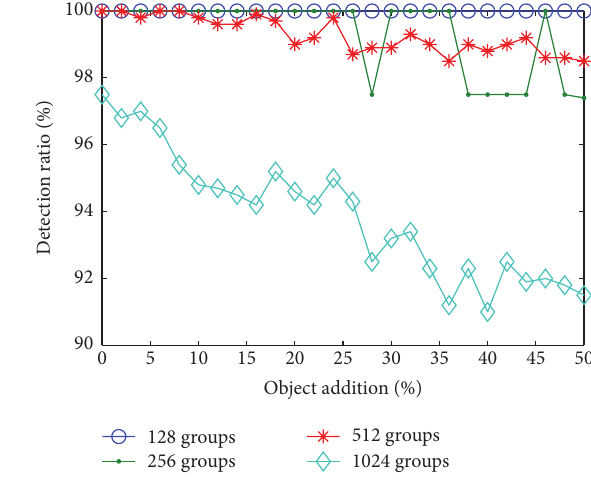
Figure 6: Resistance to object addition.